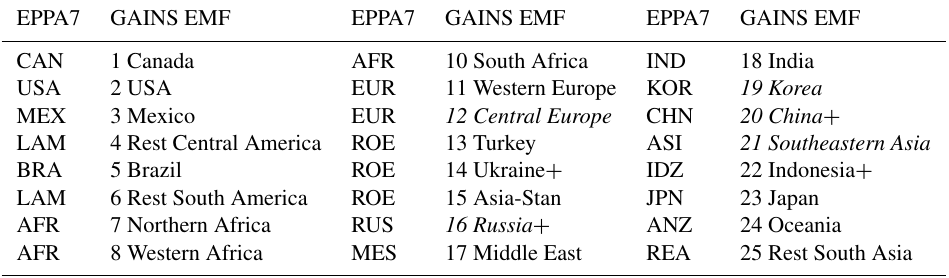
Table C1. Mapping from GAINS EMF (based on IMAGE) to EPPA7 regions.